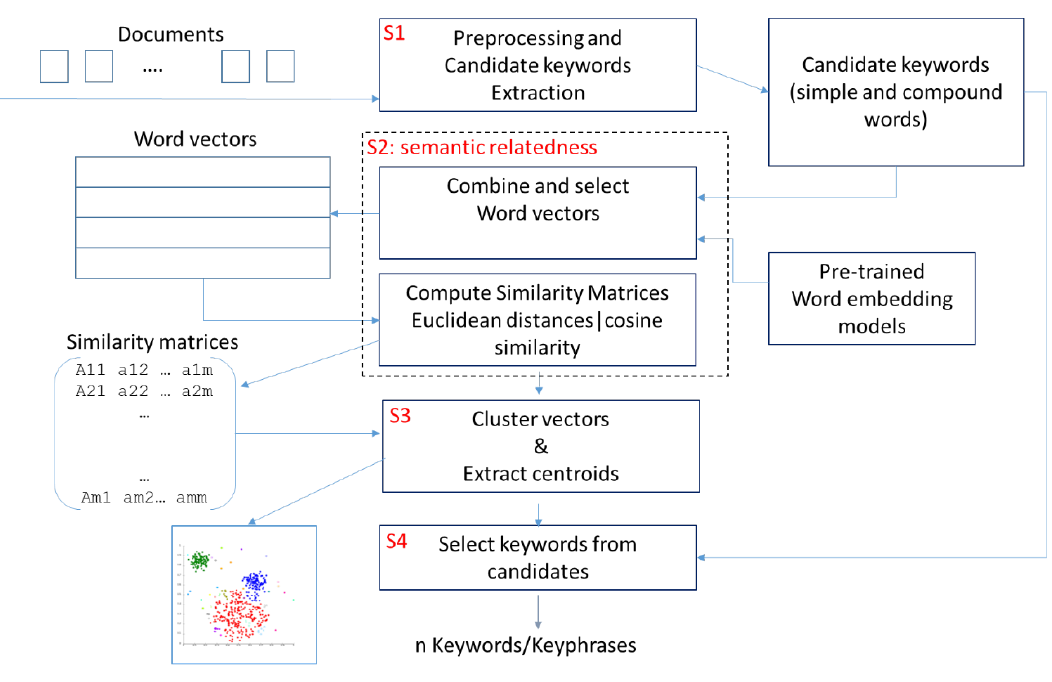
Figure 1. Schema of the method presented.